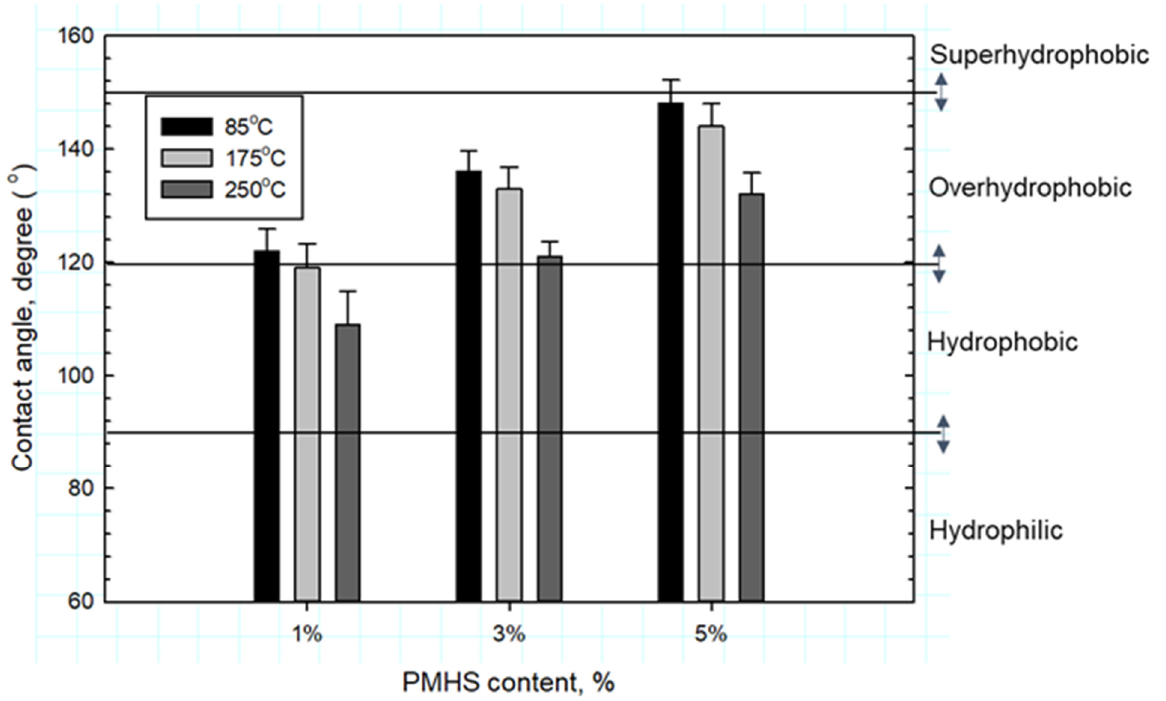
Figure 23. Water contact angle for 85°, 175°, and 250 °C-autoclaved CAC samples containing 1, 3, and 5% PMHS-treated FCS.